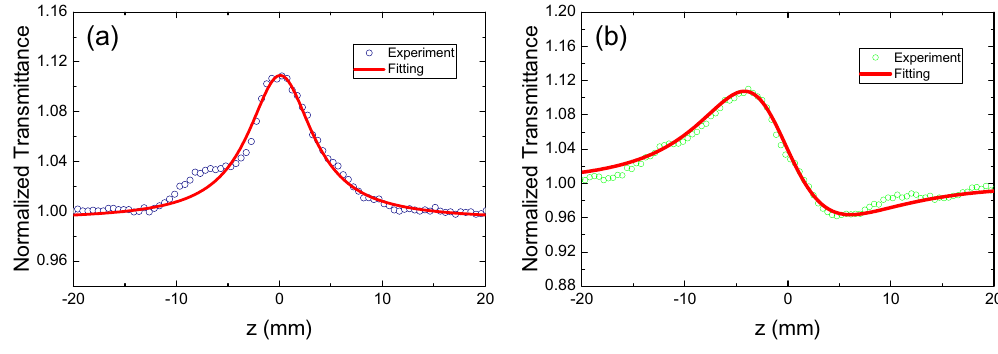
Figure 6. Plots for the ( a ) open-aperture and ( b ) closed aperture Z-scans of the ReSe 2 film.